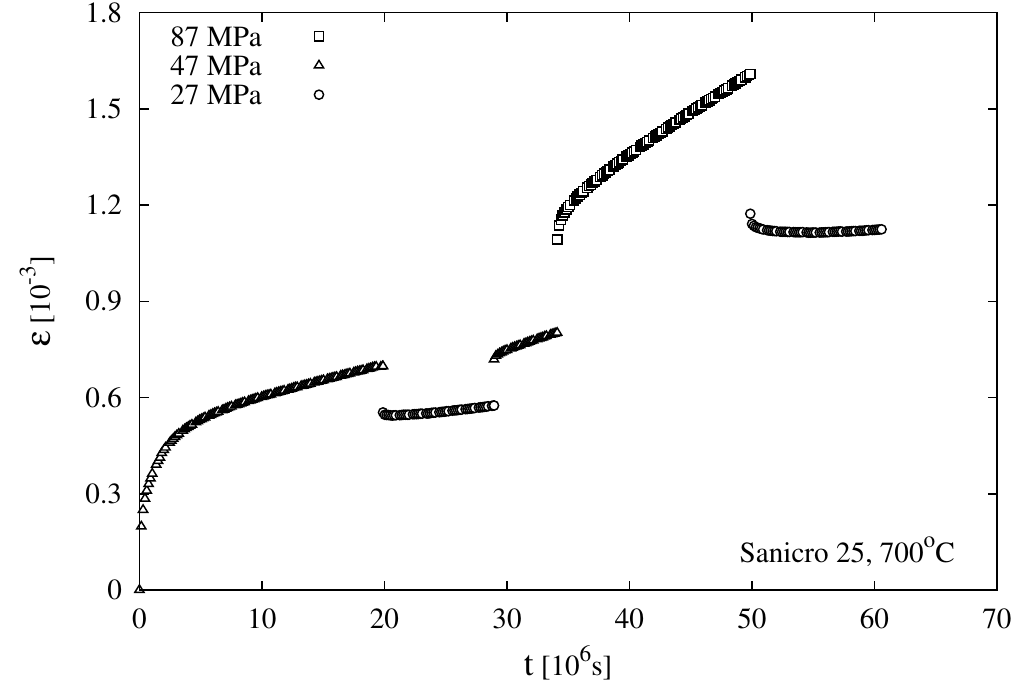
Figure 2. Creep curves at 700 ◦ C and stresses from 27 to